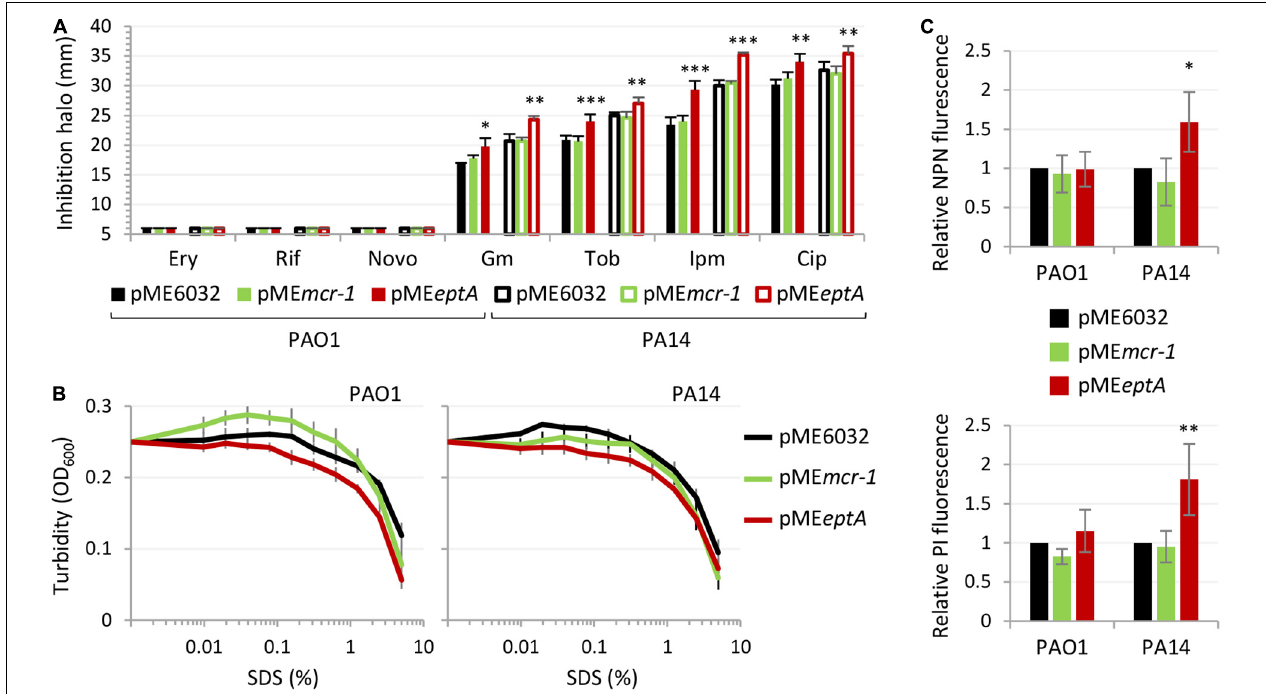
FIGURE 4 | Effect of MCR-1 or EptA overexpression on antibiotic sensitivity and cell envelope integrity. (A) Inhibition halos in the Kirby–Bauer disc diffusion assay of erythromycin (Ery), rifampicin (Rif) novobiocin (Novo), gentamicin (Gm), tobramycin (Tob), imipenem (Ipm), or ciprofloxacin (Cip) for PAO1 or PA14 containing pME6032, pME mcr-1 , or pME eptA . (B) Lytic effect of SDS, measured as decrease in cell suspension turbidity (OD 600 ), on PAO1 or PA14 cells containing pME6032, pME mcr-1 , or pME eptA . (C) Uptake of NPN (upper panel) and PI (lower panel) by PAO1 or PA14 cells containing pME6032, pME mcr-1 , or pME eptA , reported as fluorescence emission relative to the empty plasmid controls. In all the assays, strains were cultured in the presence of 0.5 mM IPTG. Data represent the mean ( ± SD) of three (A,B) or five (C) independent experiments. Asterisks indicate a statistically significant difference with respect to the corresponding empty plasmid control ( ∗ P < 0.05, ∗∗ P < 0.01, ∗∗∗ P < 0.001;